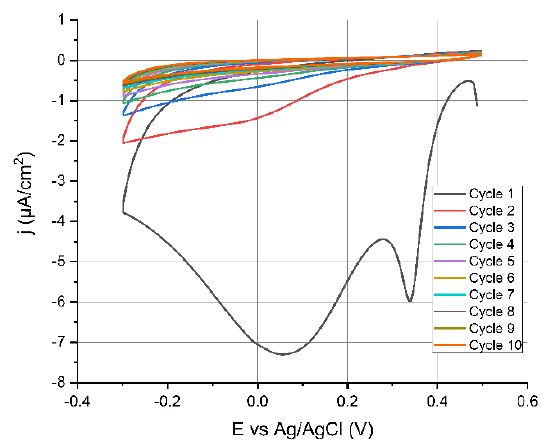
Figure 3. CV of 2.5 mmol · L − 1 4-CBD +50 mmol · L − 1 NBu4BF4; v = 100 mV/s and voltage range +0.5 to − 0.3 V.